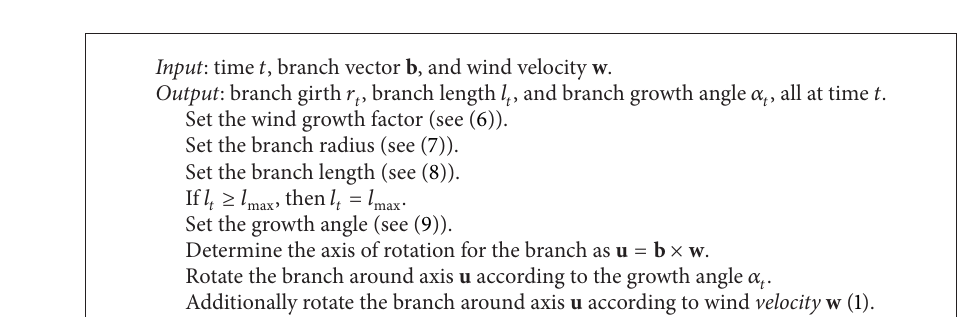
Figure 3: Branch segments and nodes.